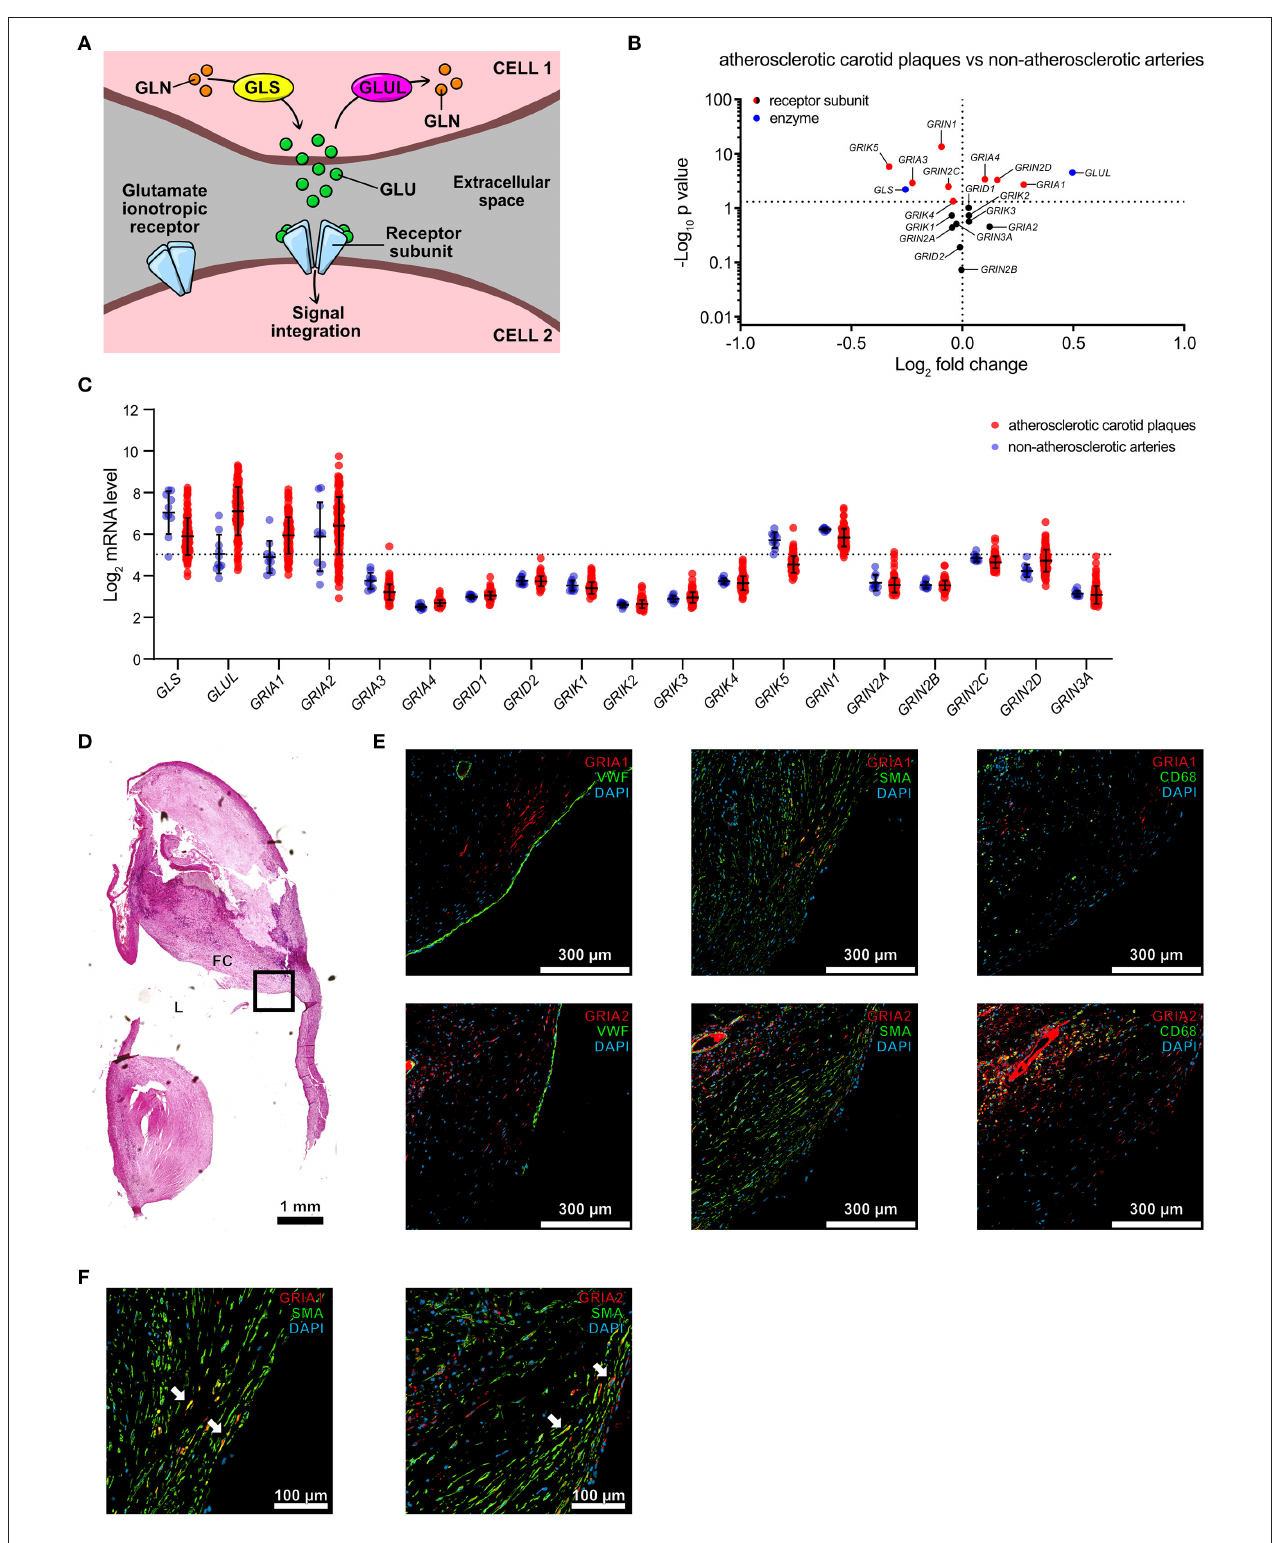
FIGURE 1 | AMPA-type glutamate receptors are expressed in human atherosclerotic plaques. (A) Schematic representation of cell-to-cell glutamatergic communication mechanisms mediated by glutamate ionotropic receptor receptors (Gln, Glutamine; Glu, glutamate; GLS, glutaminase; GLUL, glutamine